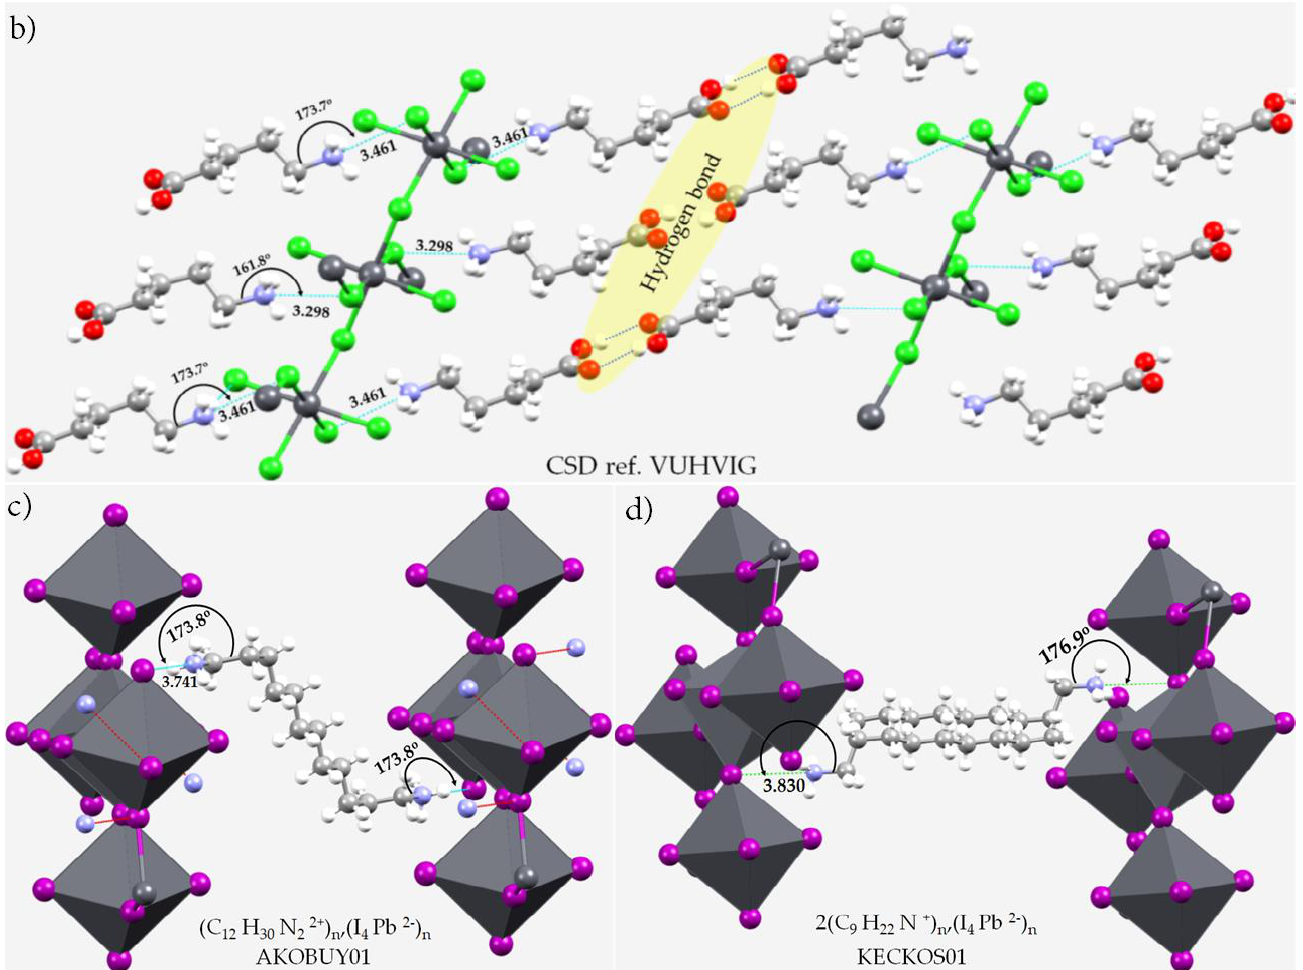
Figure 14. Mixed polyhedral (inorganic) and ball-and-stick (organic) models of the crystals of ( a ) [(CH 3 (CH 2 ) 15 NH 3 )PbI 4 ] [108]; ( b ) [C 5 H 12 NO 2+ ] 4 [Pb 2 Cl 8 ] n; [109]; ( c ) [(H 3 N(CH 2 ) 12 NH 3 )PbI 4 ] [110]; and ( d ) [(CH 3 (CH 2 ) 8 NH 3 )PbI 4 ] [111]. Bond lengths and bond angles associated with selected intermolecular interactions are in Å and degrees, respectively. Space groups and CSD ref codes are shown for each case.